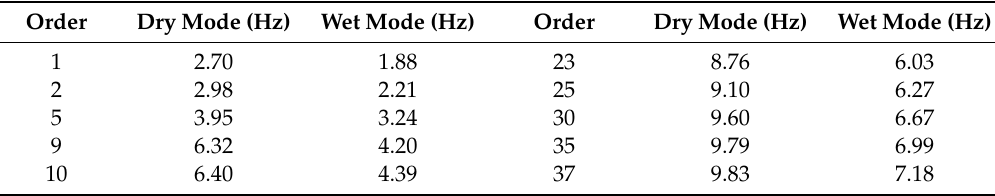
Table 2. Natural frequencies of the dam.